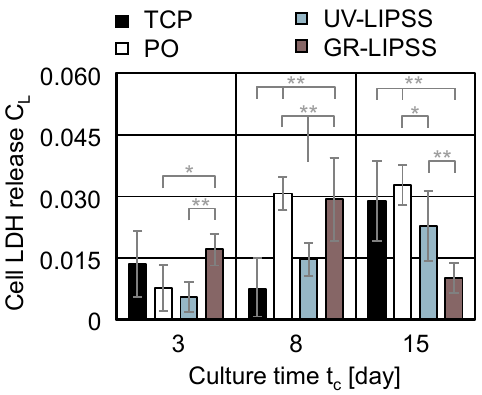
Figure 7. Cell lactate dehydrogenase (LDH) release C L on TCP, PO, UV-LIPSS, and GR-LIPSS. Statistical analysis by ANOVA and Tukey’s test for determination of statistically significant differences (n = 10 each group, * for p < 0.05, ** for p < 0.01).